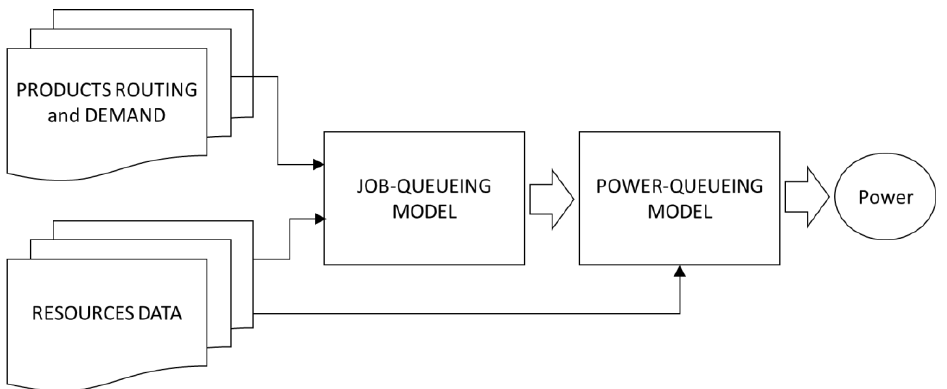
Figure 1. Job-queueing and power-queueing models relationship [3].